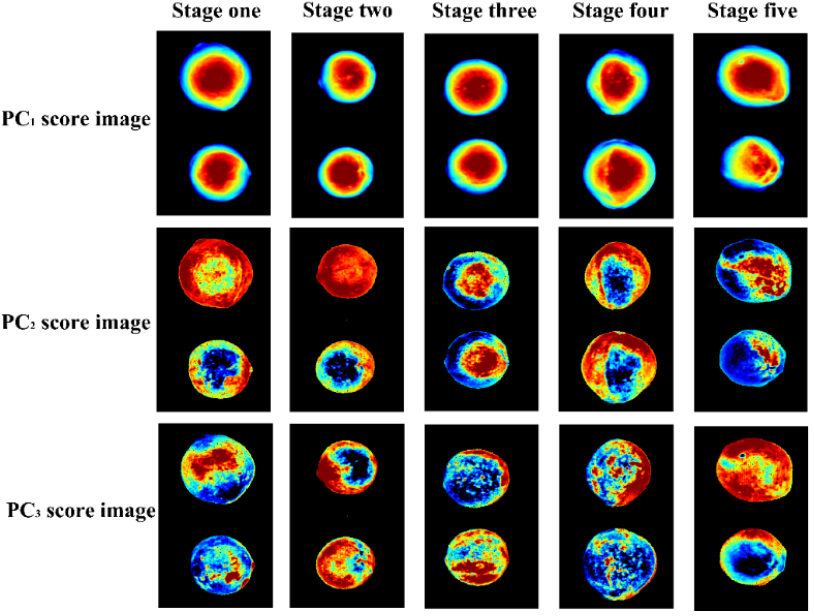
Figure 6. The first three PC-score images of the samples at five maturity stages. PC, principal component. Table 2. Results of PLS-DA and PCA-DA models based on the full spectra using various pre- processing